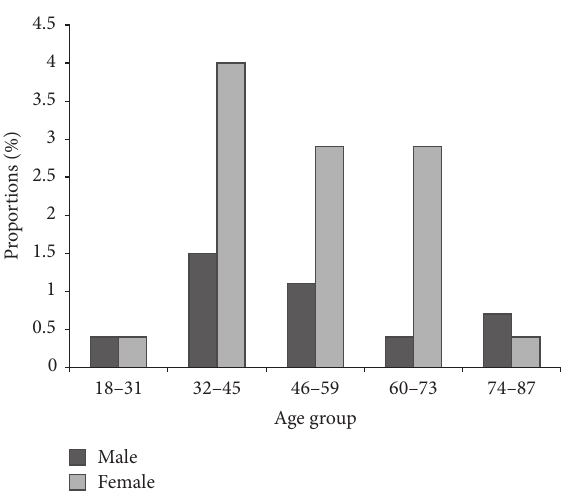
Figure 3: Age distribution of scrotal hydrocoele pathology accord- ing to stages in those examined individuals. HC: hydrocoele; HC&LE: hydrocoele and